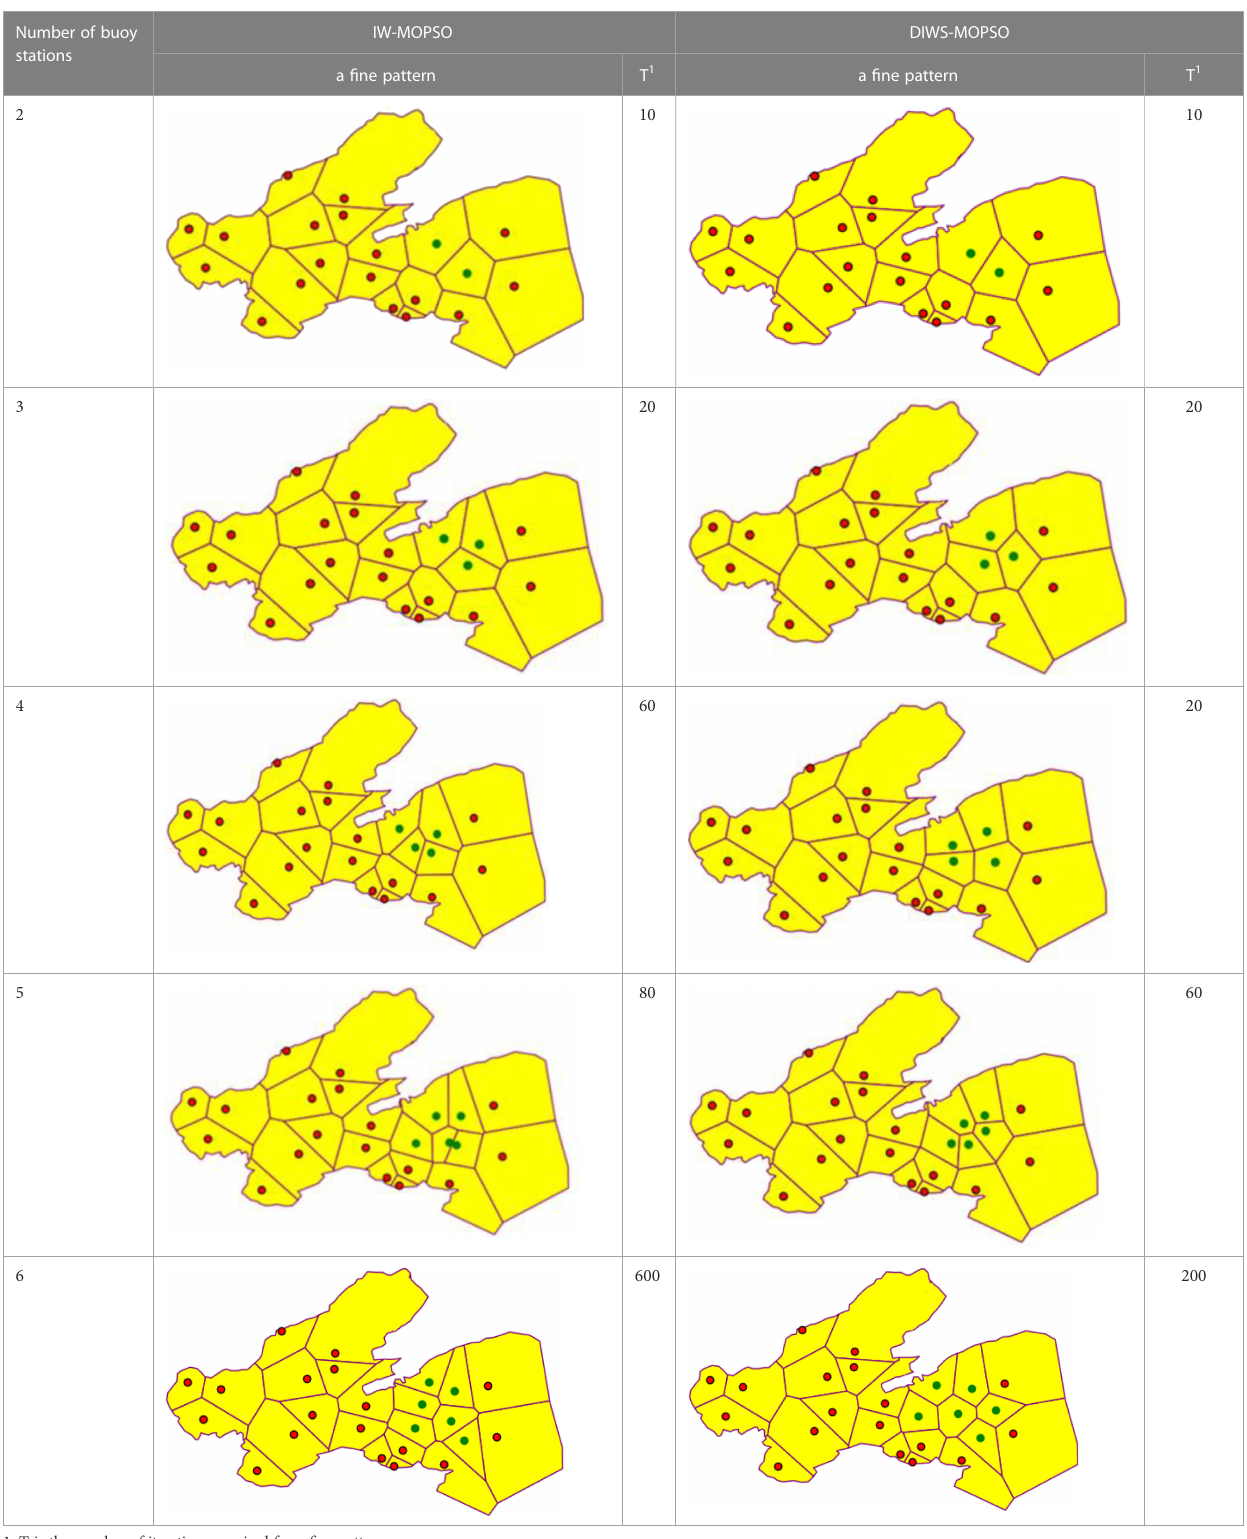
TABLE 1 Comparison of selection results of multi-buoy stations